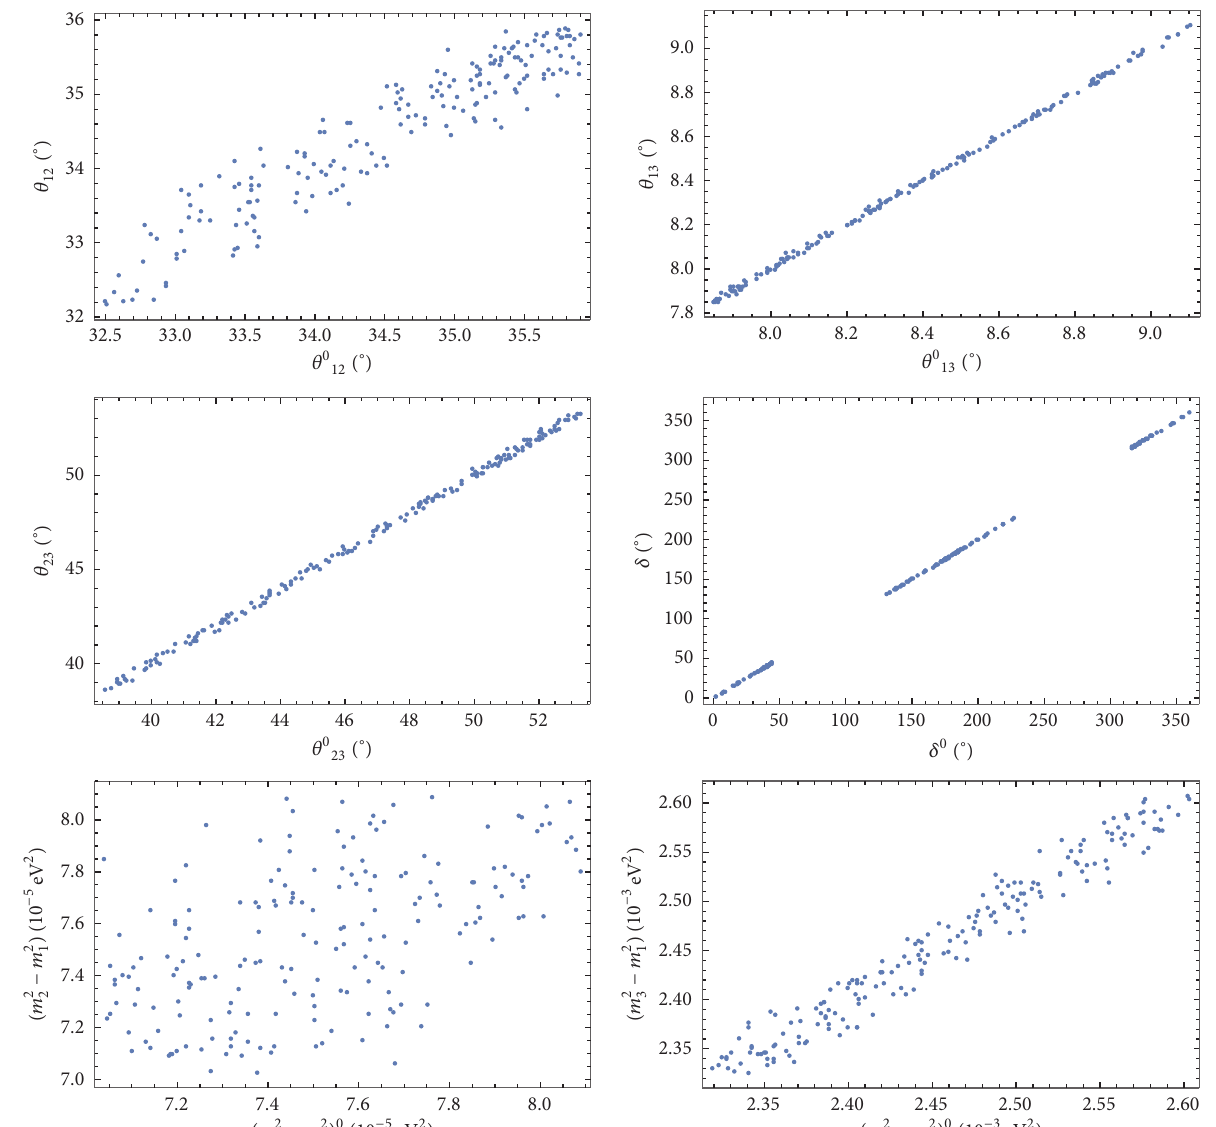
Figure 4: Correlations of neutrinos oscillation parameters before and after the perturbation with the parameter 𝜖 2